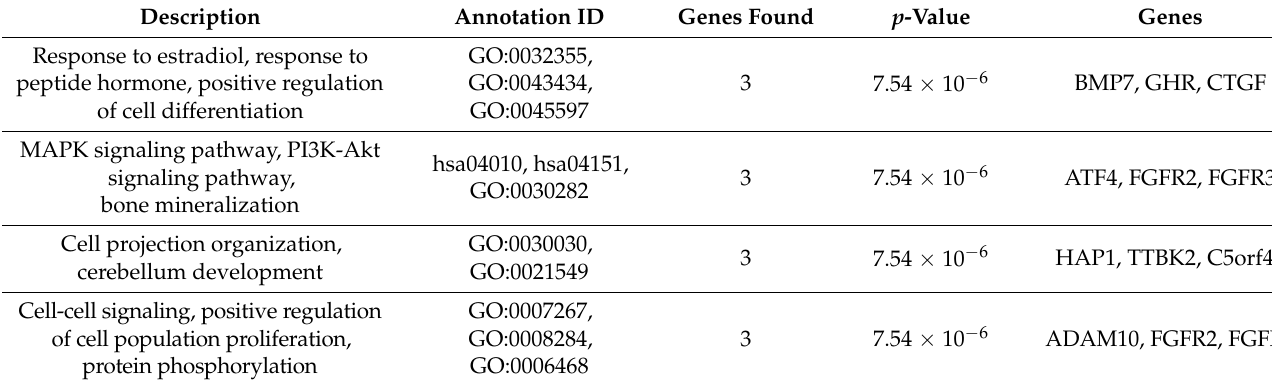
Table 2. Top 10 GO terms of downregulated